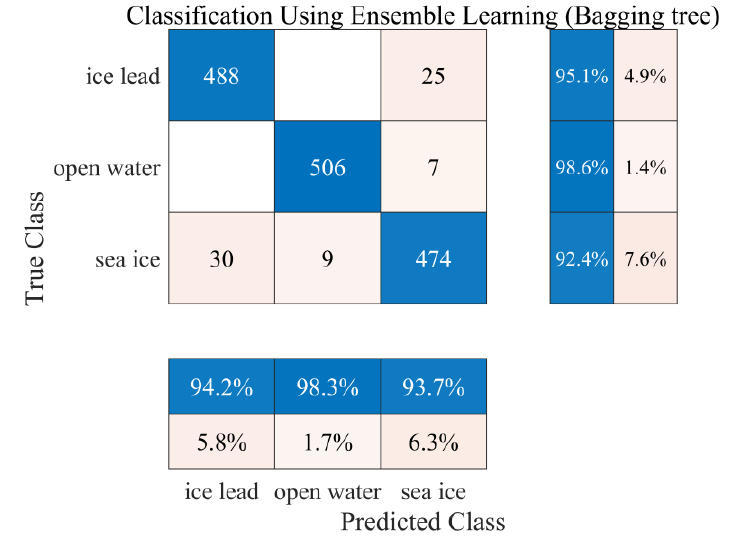
Figure 12. Confusion matrix of Bagging classifier.